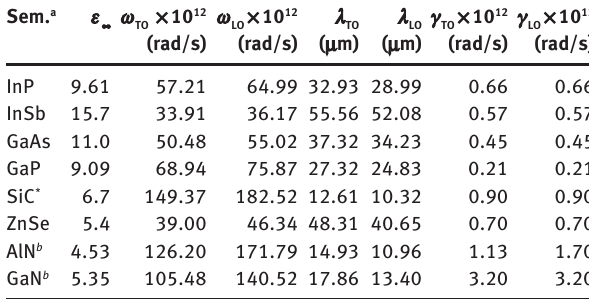
Table 2: Ionic permittivity model parameters of widely-used semiconductors.